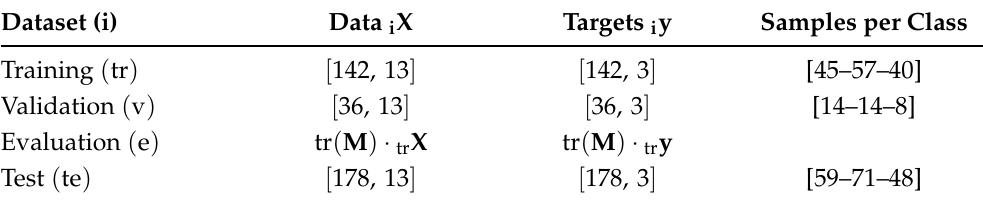
Table 1. Dataset size, dimensionality, and number of samples per class.